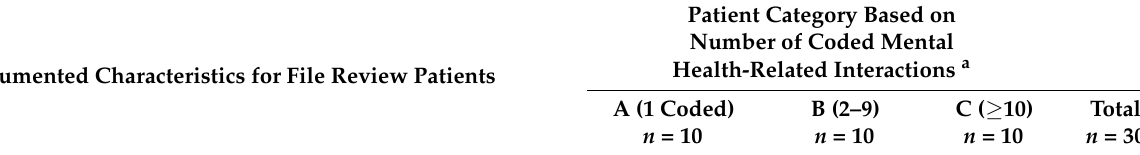
Table 5. Characteristics of patients and clinical response for file review patients during